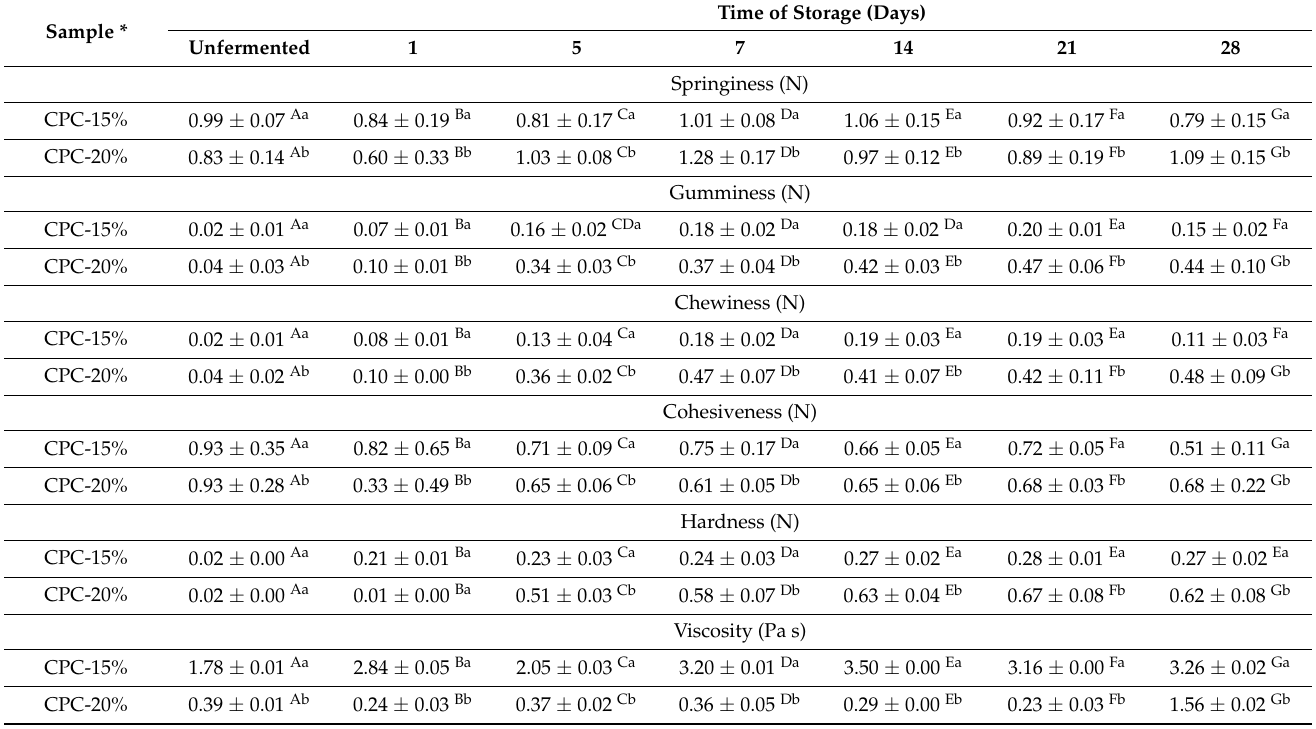
Table 4. Textural characteristics and viscosity of the